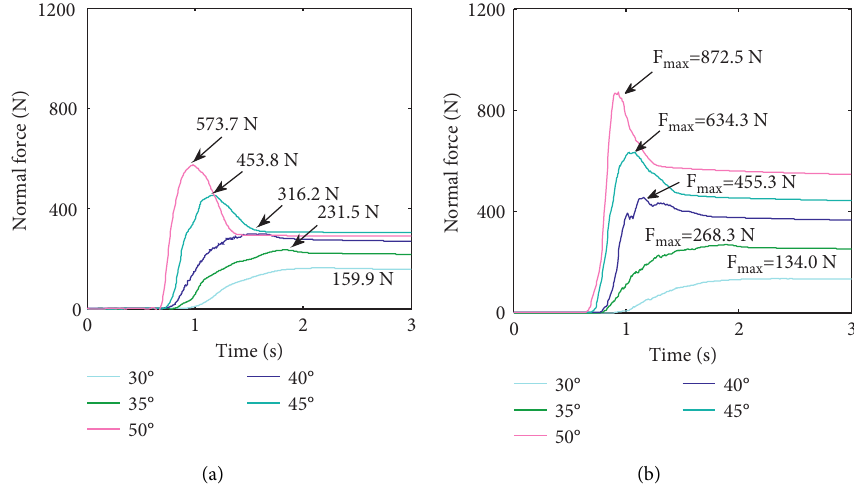
Figure 7: Evolution of the normal impact loads on the rigid wall: (a) tilted wall and (b) vertical